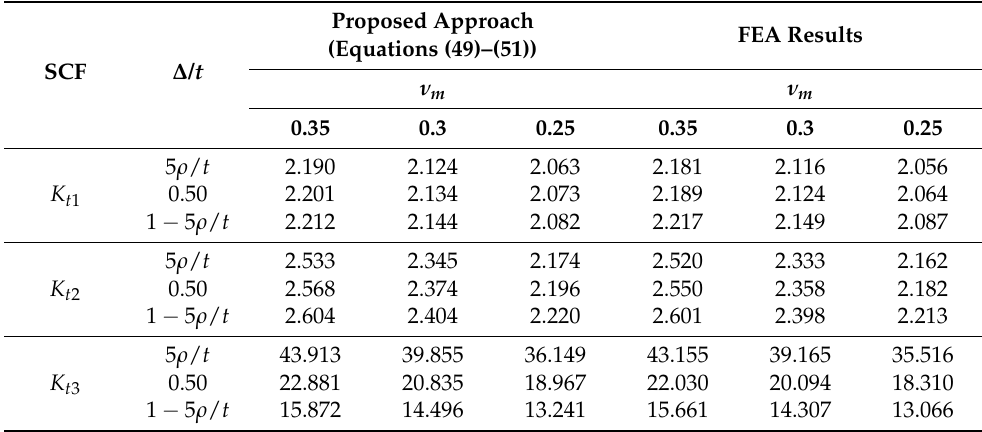
Table 1. Comparison of analytical and finite element analysis (FEA) results of stress concentration factors (SCFs) near the cavity of radius of 0.5 mm and κ = 15.5.